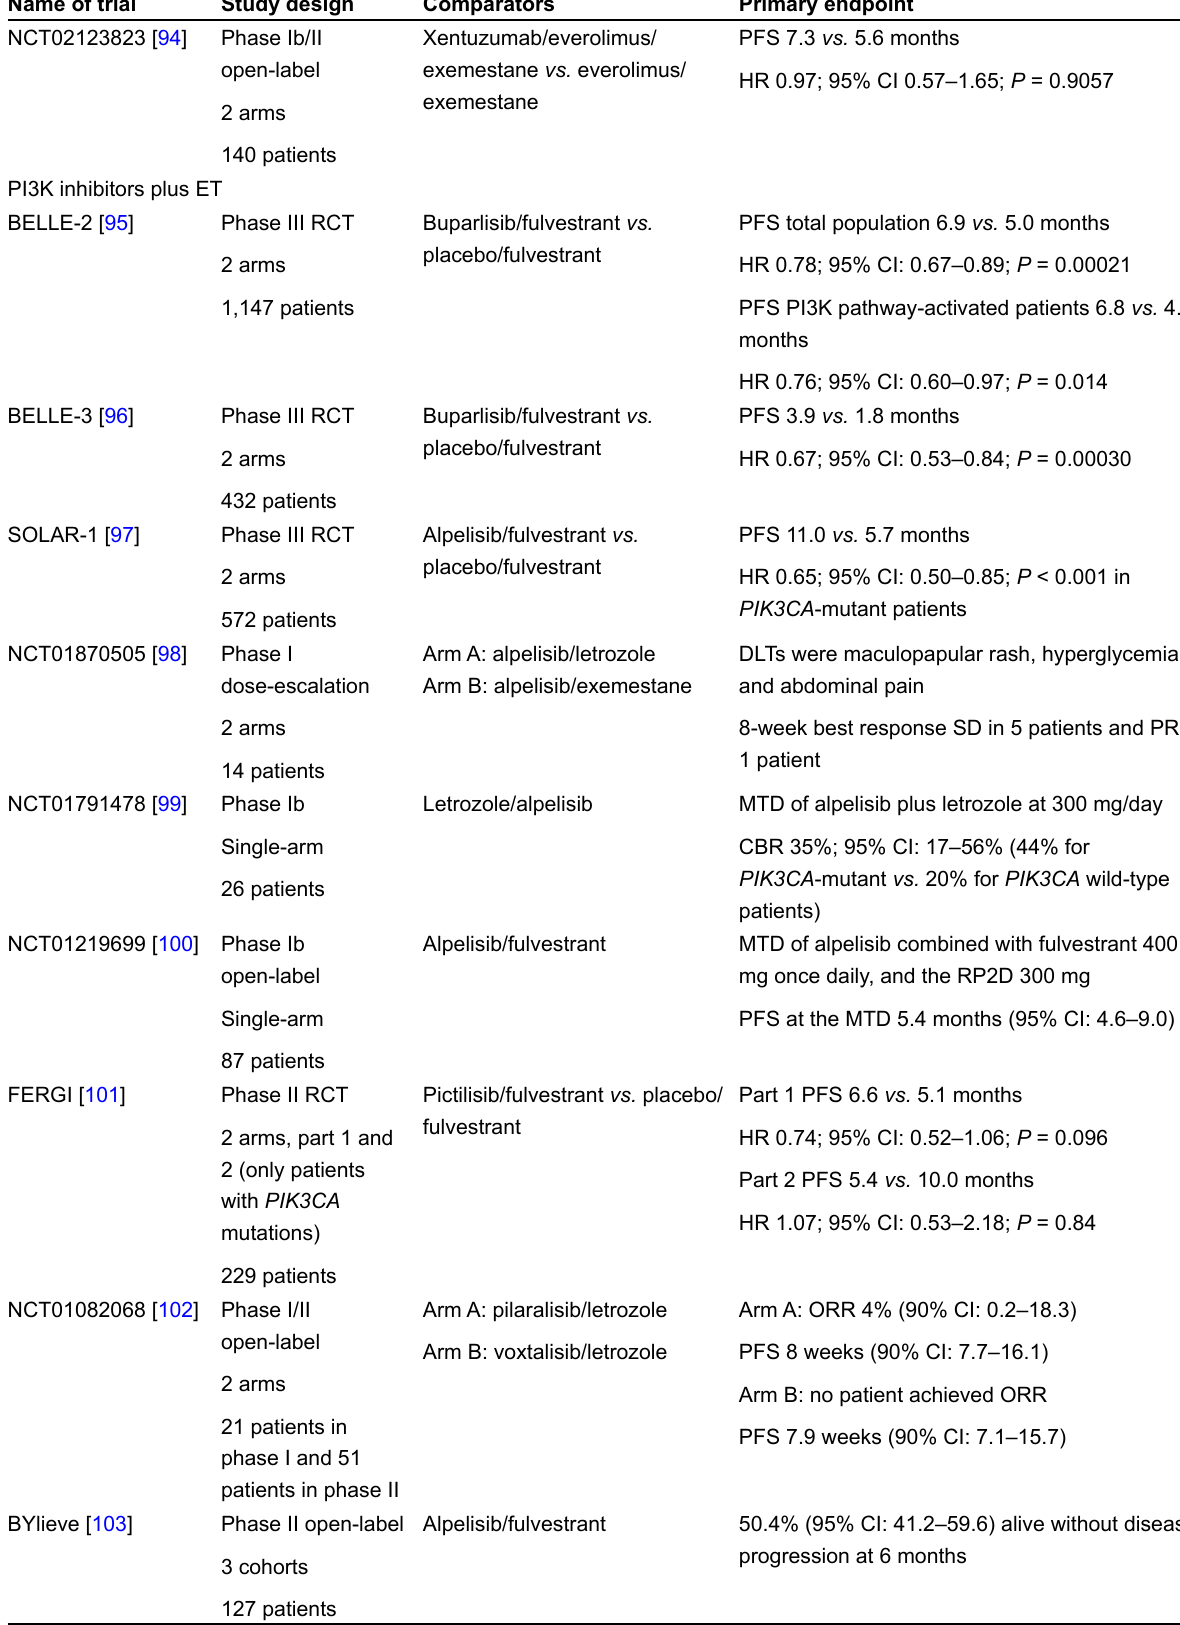
Table 1. Published clinical trials combining ET and inhibitors of the PI3K/Akt/mTOR pathway ( continued ) Name of